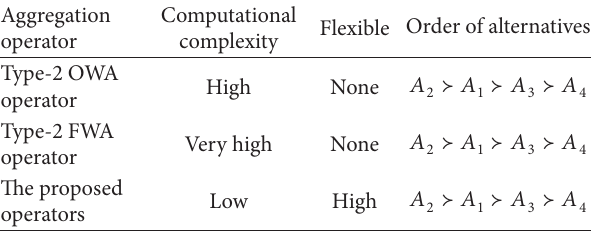
Table 8: Comparisons with type-2 OWA and type-2